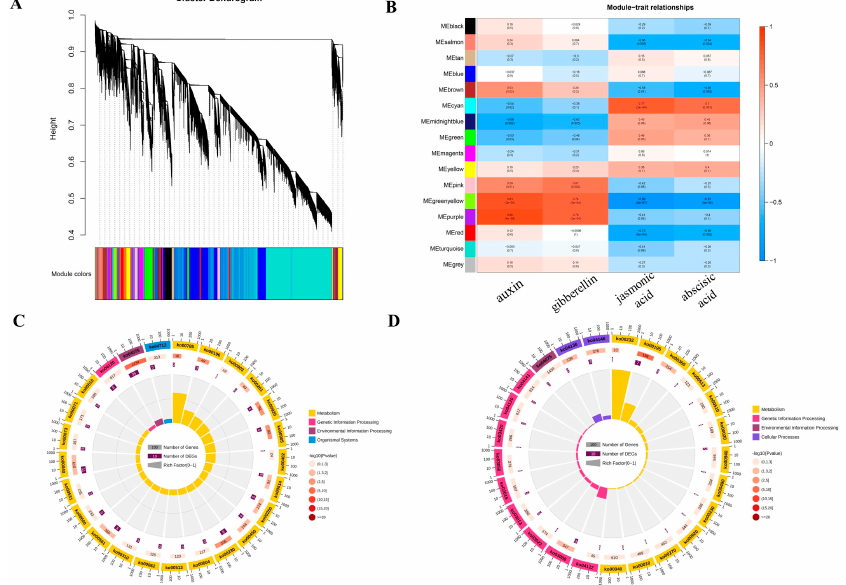
Figure 5. Weighted gene co-expression network analysis (WGCNA) of RNA-sequencing data from diploid and tetraploid poplar 84K. ( A ) Hierarchical clustering dendrogram of co-expression modules identified by WGCNA. Every branch on the tree represents one gene. ( B ) Association analysis of gene co-expression network modules with hormone contents. The horizontal axis represents different samples, and the vertical axis represents the eigenvectors of each module. The red grid represents a positive correlation between the physiological trait and the module. ( C ) KEGG pathway enrichment analysis of genes in the purple module. ( D ) KEGG pathway enrichment analysis of genes in the cyan module.